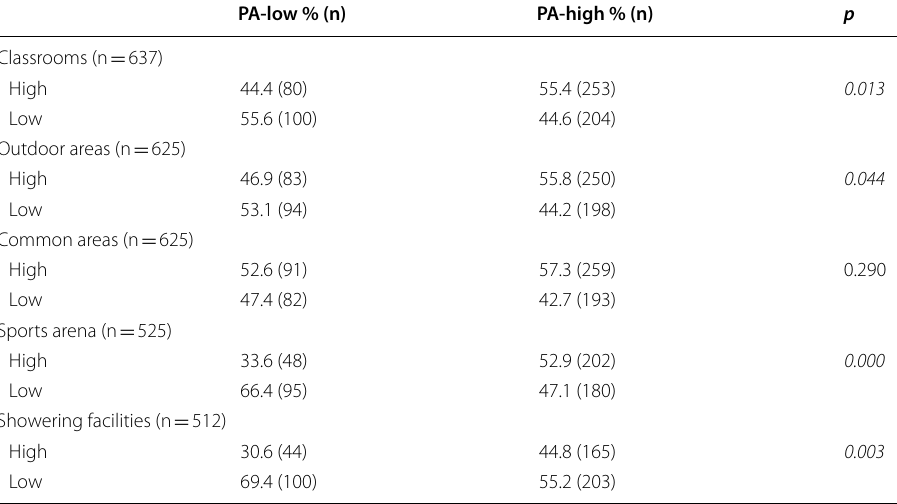
Italic values are statistically significant (p